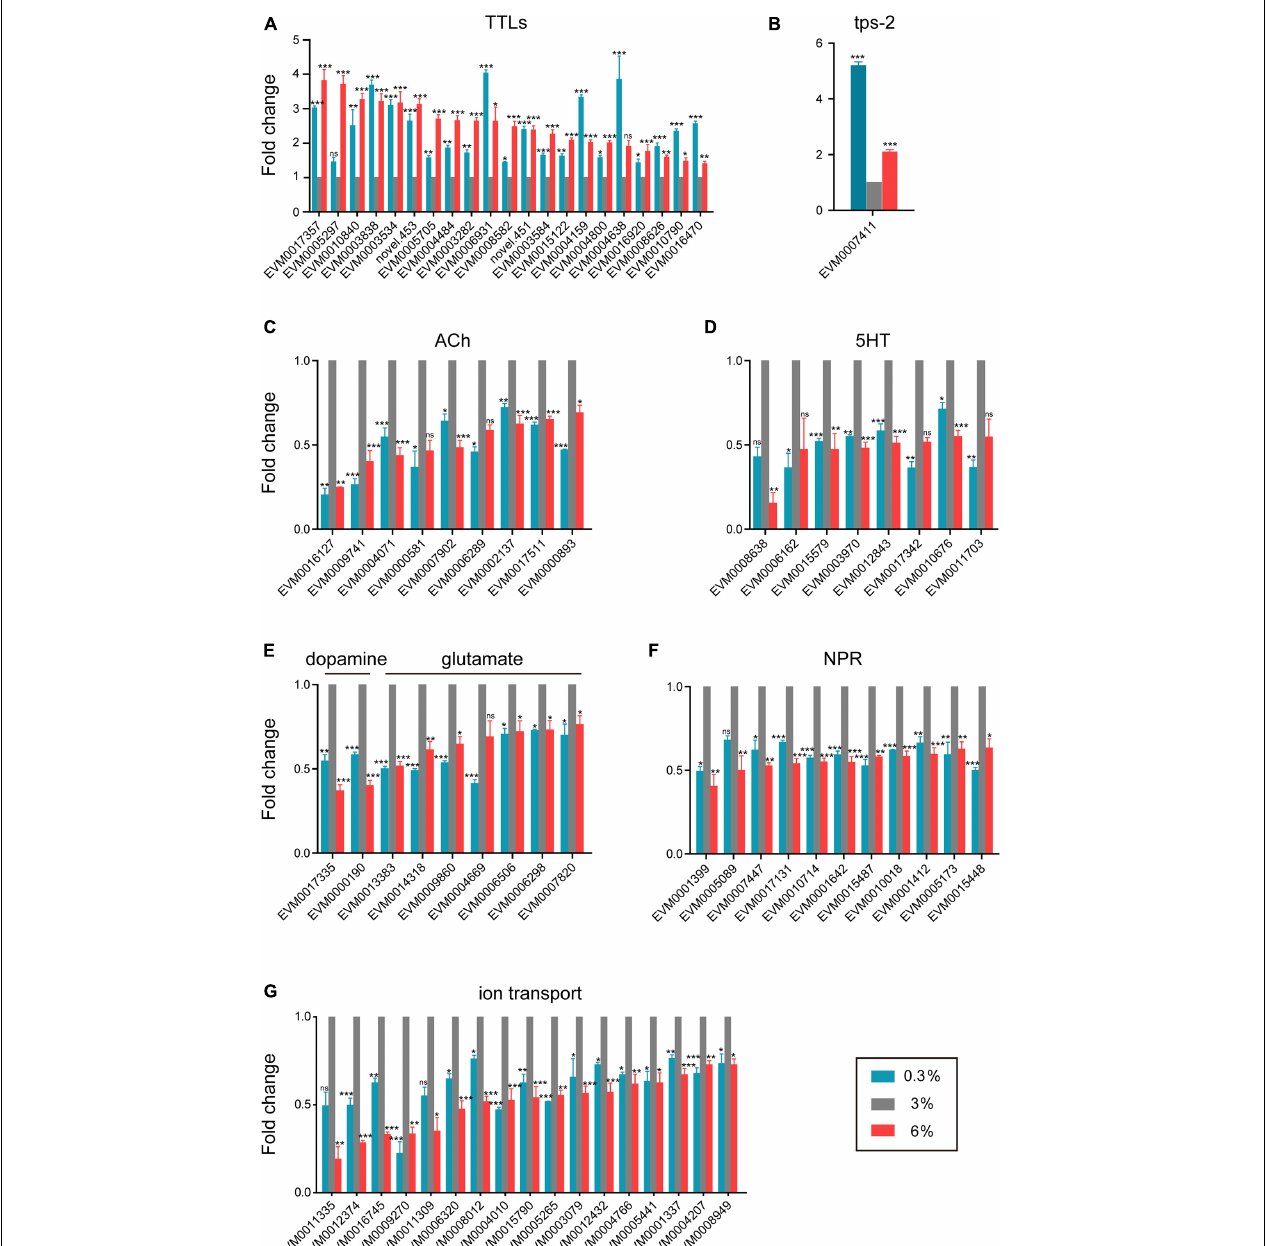
FIGURE 3 | Shared transcriptomic signature under both hyposaline and hypersaline environments. (A) Expression level of transthyretin-like family genes (TTLs). (B) Expression level of trehalose-6-phosphate synthase gene (tps-2). (C) Expression level of acetylcholine receptor genes (ACh). (D) Expression level of serotonin receptor genes (5HT). (E) Expression level of dopamine and glutamate receptor genes. (F) Expression level of neuropeptide receptor genes (NPR). (G) Expression level of ion transporter genes. Fold change indicates the ratio of FPKM value of the treatment group (0.3%, 6%, as indicated) to that of the control group (3%). The error bars represent standard error of the mean of three biological replicates per condition. The comparisons between the treatment and control groups were analyzed statistically using the Benjamini and Hochberg’s methods calculated by DESeq2. The value of padj < 0.05 was considered statistically significant. *padj < 0.05, **padj < 0.01, ***padj < 0.001, ns–not